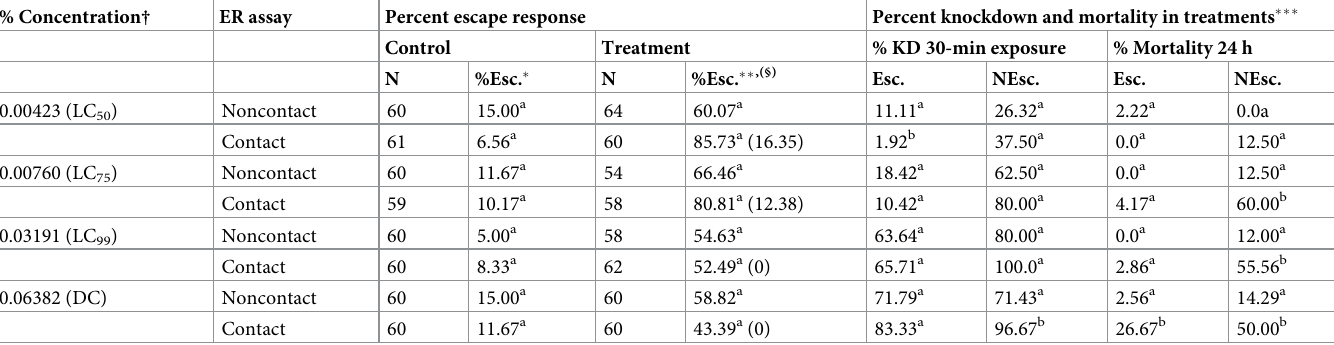
Table 2. Mean percent escape response and percent mortality of An . minimus (DDC) exposed to TFT in ER